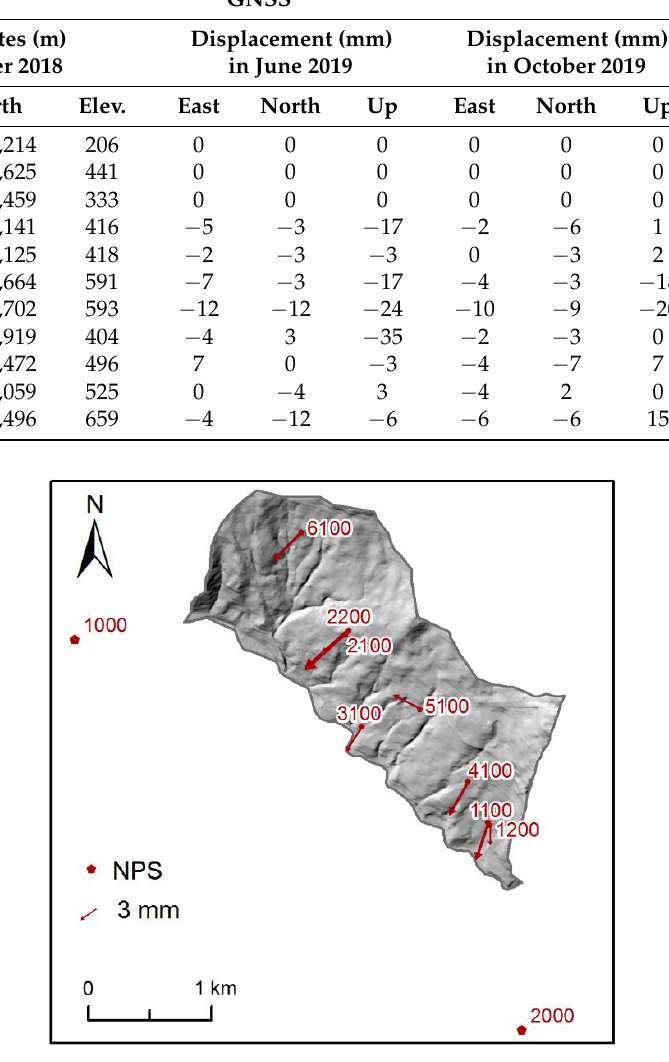
Figure 9. Cumulative horizontal displacement vectors evaluated by GNSS survey.